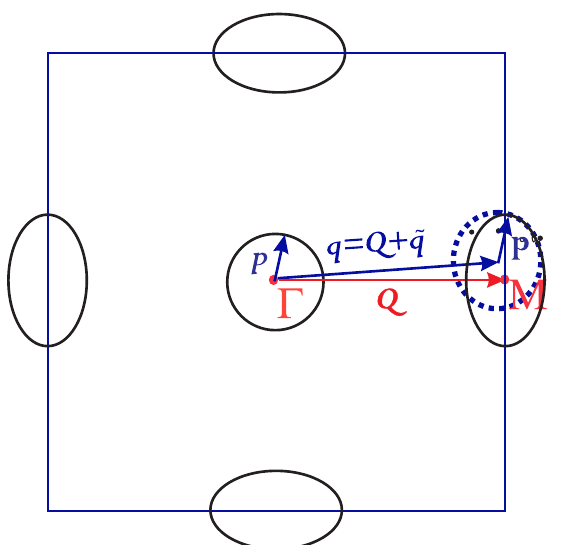
Figure 2. Schematic plot of the band structure. The blue dashed circle represents the shift of the hole pocket at Γ by = +  q Q q